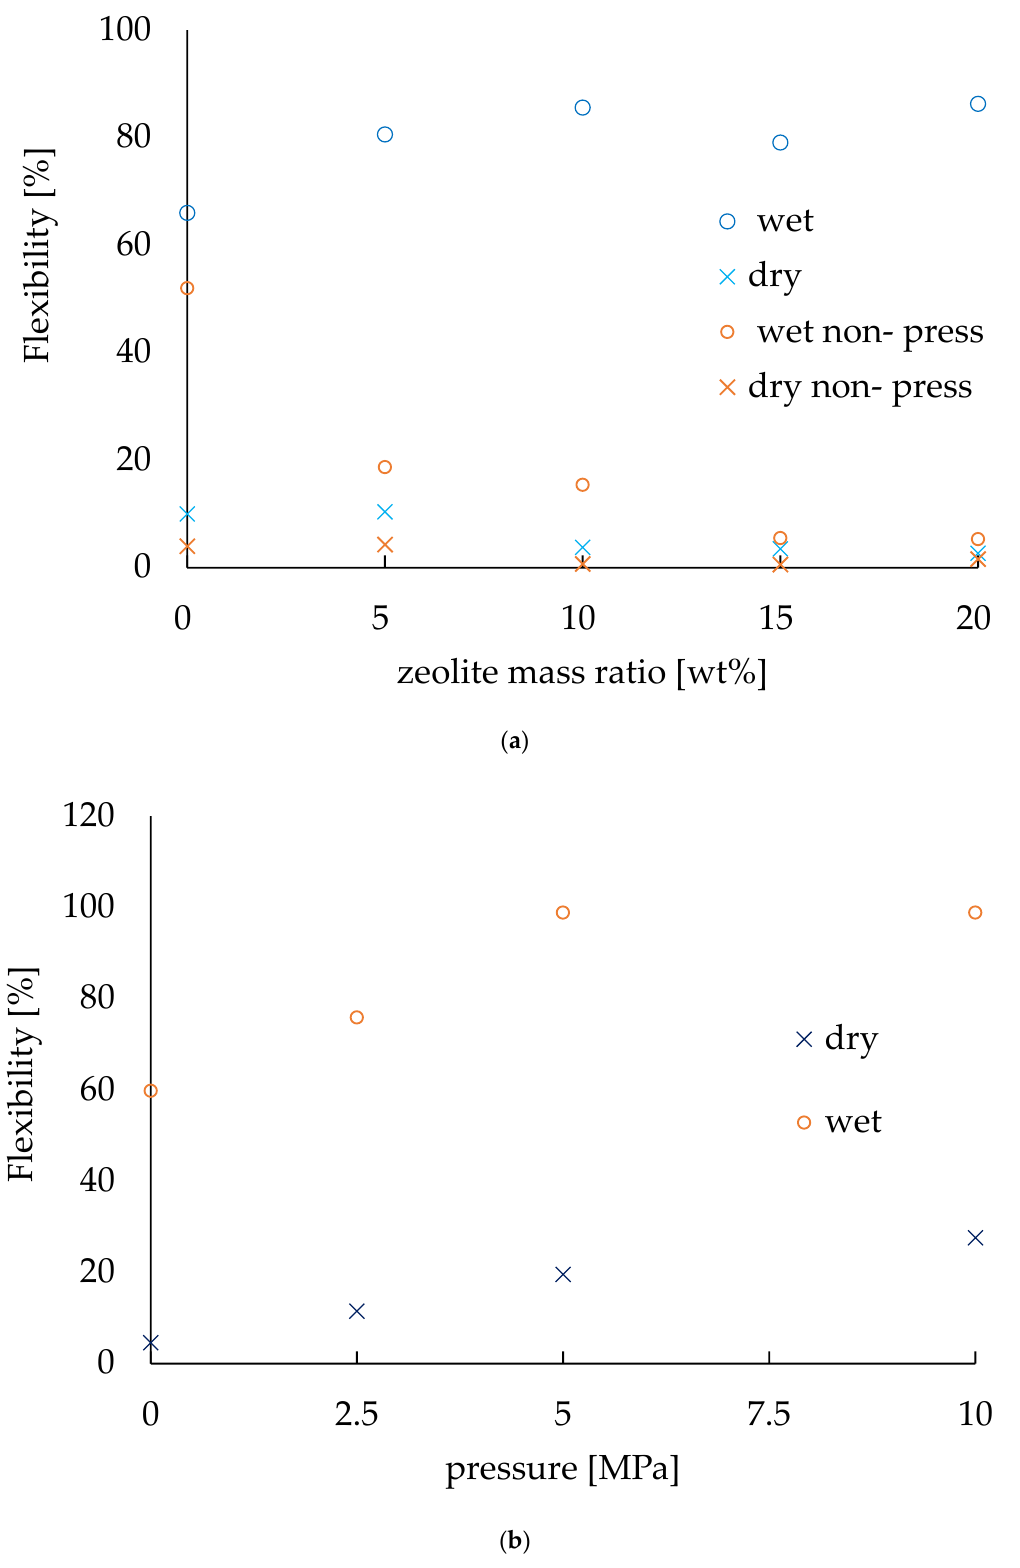
Figure 5. Evaluation of flexibility. ( a ) Flexibility varies with the amount of zeolite. ( b ) Flexibility depends on the pressure applied during fabrication.